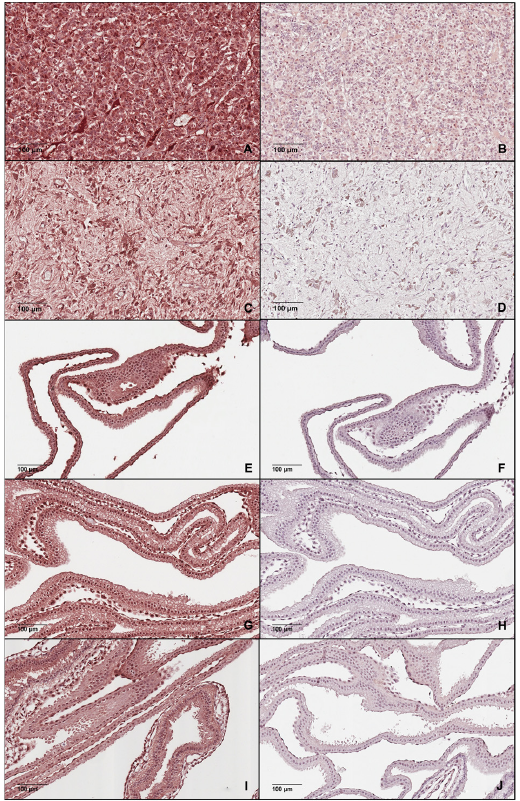
Figure 7. Photomicrograph of the equine adenohypophysis ( A ) and neurohypophysis ( C ) as the positive control tissues with intense staining for the Leucyl and cystinyl aminopeptidase (LNPEP) and its corresponding negative epitope control (( B , D ), respectively) and the equine embryonic membranes at Day 15 ( E , F ), Day 16 ( G , H ) and Day 18 ( I , J ) post-ovulation demonstrating immunostaining for LNPEP of the trophectoderm and endoderm ( E , G , I ) and the corresponding negative epitope control ( F , H , J ).